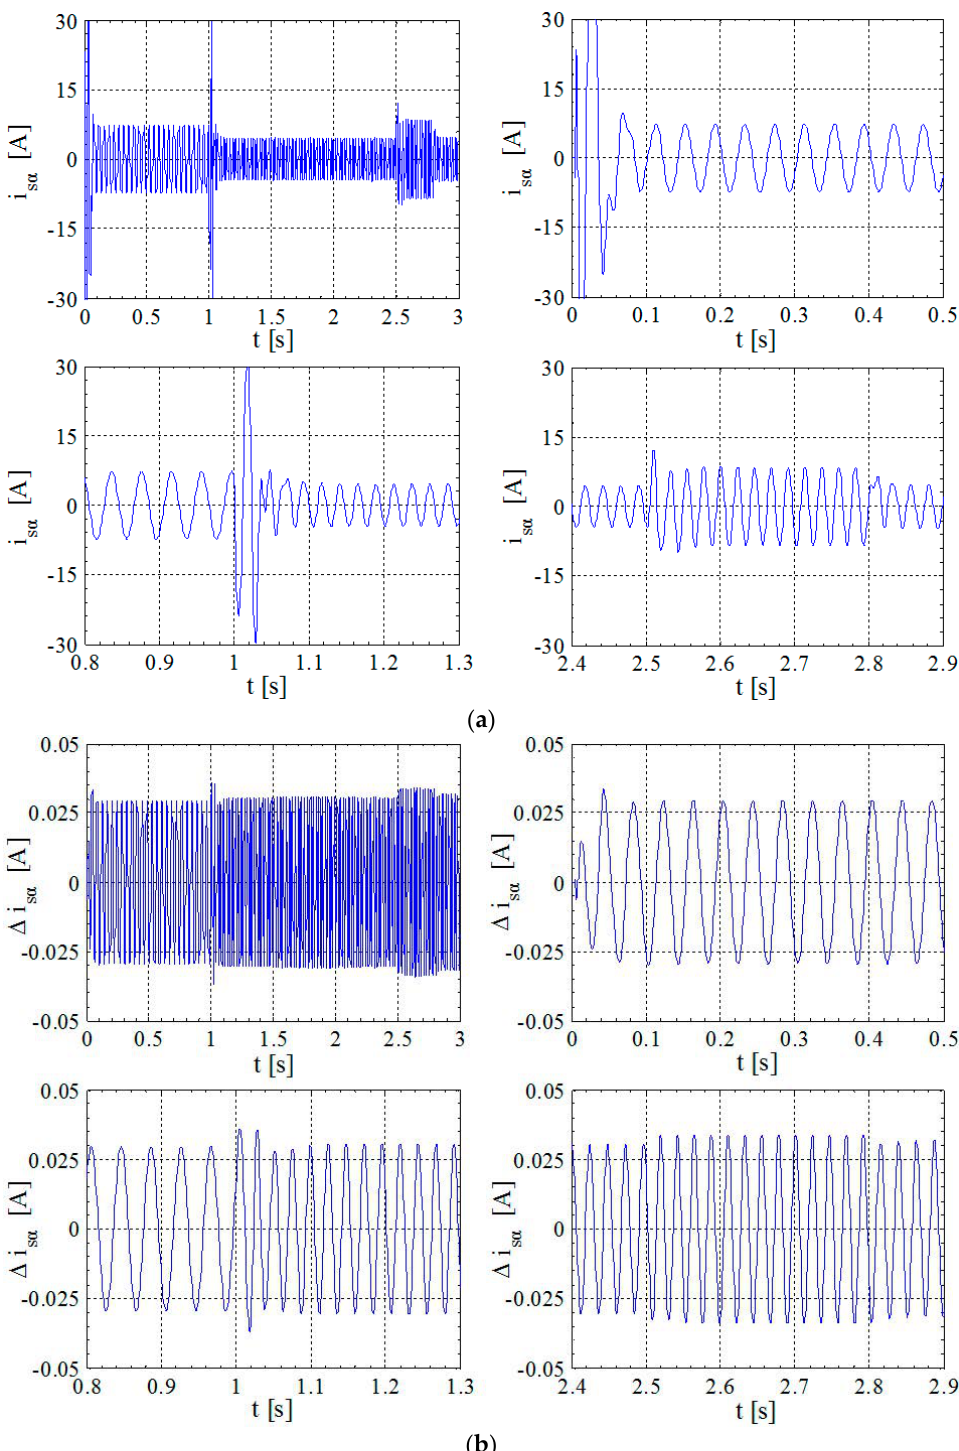
Figure 8. Observation response of α -axis stator current: ( a ) Observed α -axis current; ( b ) Observation error of α -axis current.